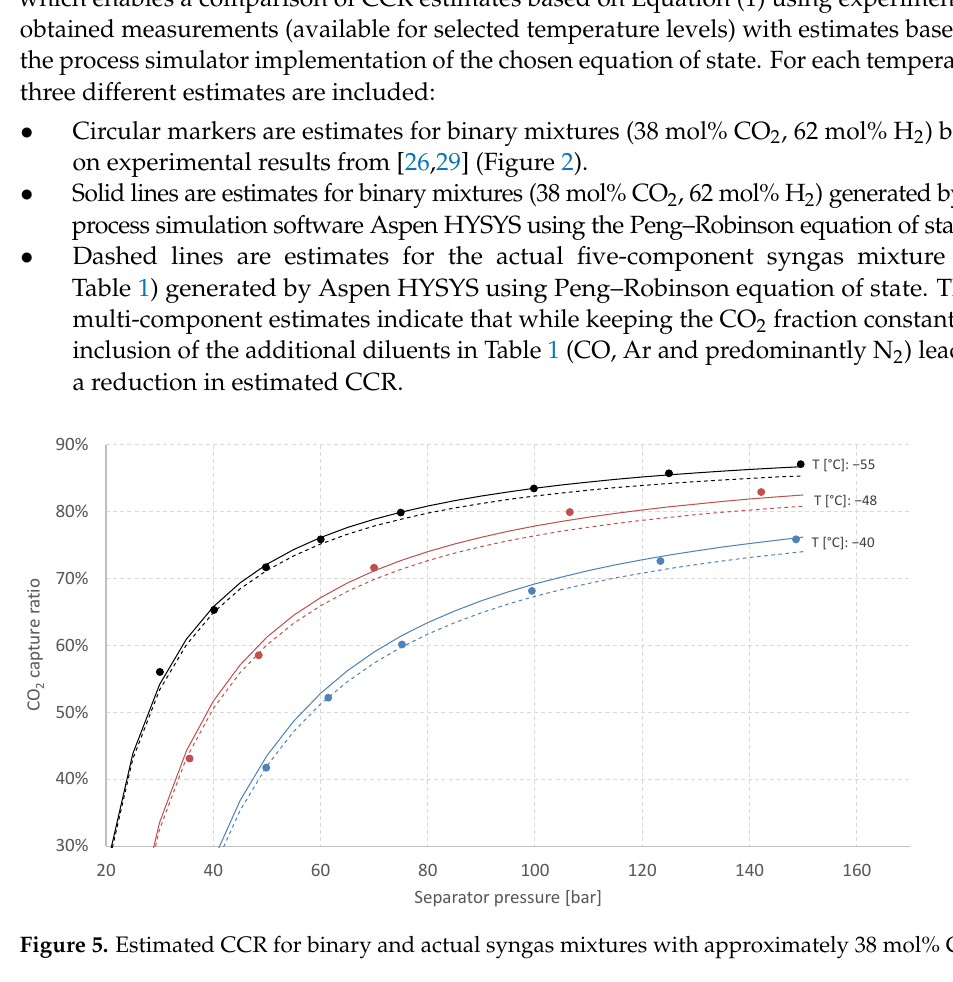
Figure 4. Estimated CO 2 capture ratio for phase separation of a binary H 2 /CO 2 mixture.